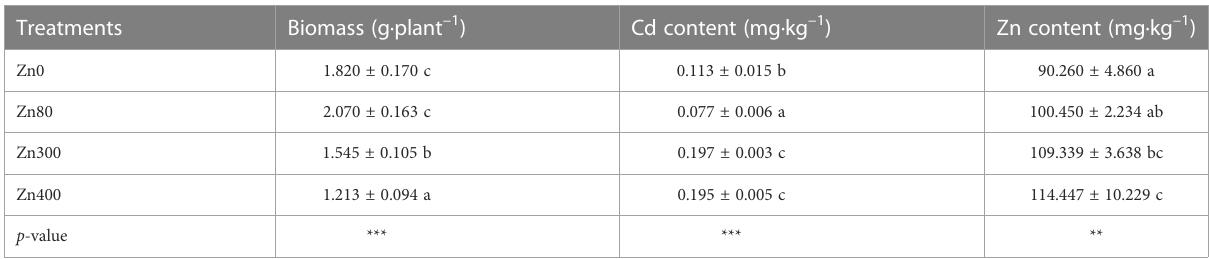
TABLE 2 Effects of ZnSO 4 treatments on biomass, cadmium content and zinc content in the leaves of cadmium contaminated K. obovata . Treatments